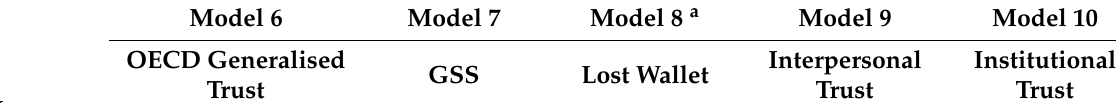
Table 4. Regression Analysis with Experimental Trustworthiness as